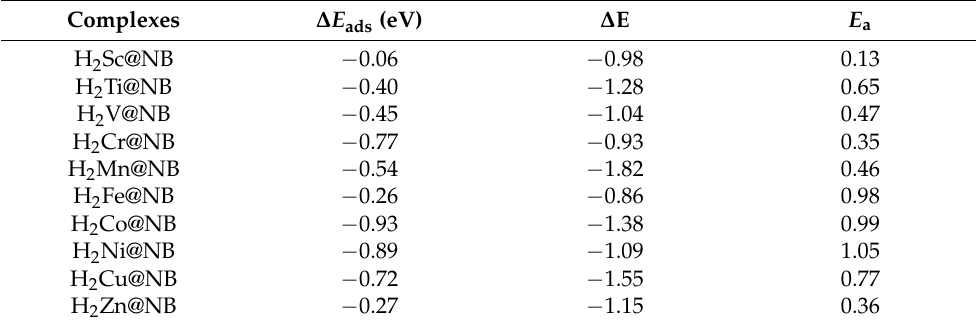
Table 2. Summary of hydrogen molecule adsorption energies ( ∆ E ads ), energy of reaction ( ∆ E), and hydrogen dissociation energy barriers ( E a ) for all studied TM@NB